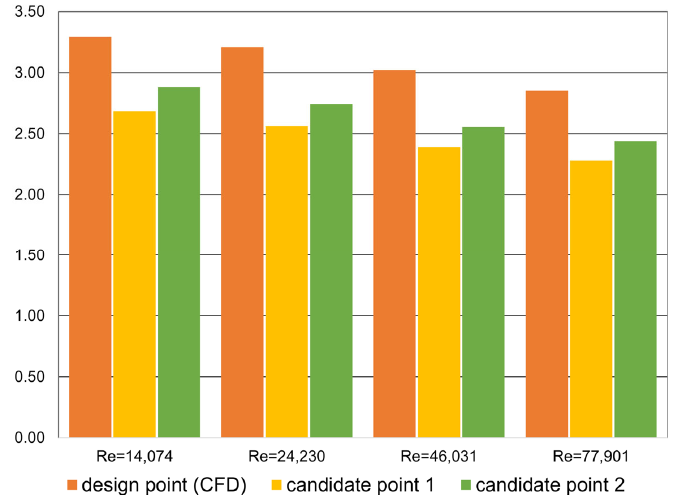
Figure 12. Comparison of the TPLC between the design point and two candidate points for four Reynolds numbers.